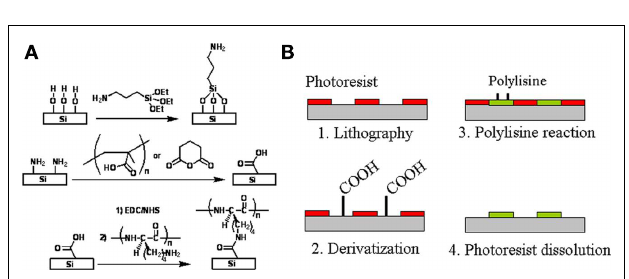
FIGURE 12 | Chemical patterning of polylysine squares. (A) Surface derivatization to successively obtain amino- and carboxylic acid-terminated surfaces on which a polylysine peptide is chemically bonded. (B) Chemical patterning is obtained by lithographically defining openings in a photoresist, derivatizing the surface, reacting it to polylysine in the presence of EDC and NHS and dissolving the photoresist. Adapted from Diaz-Quijada et al.